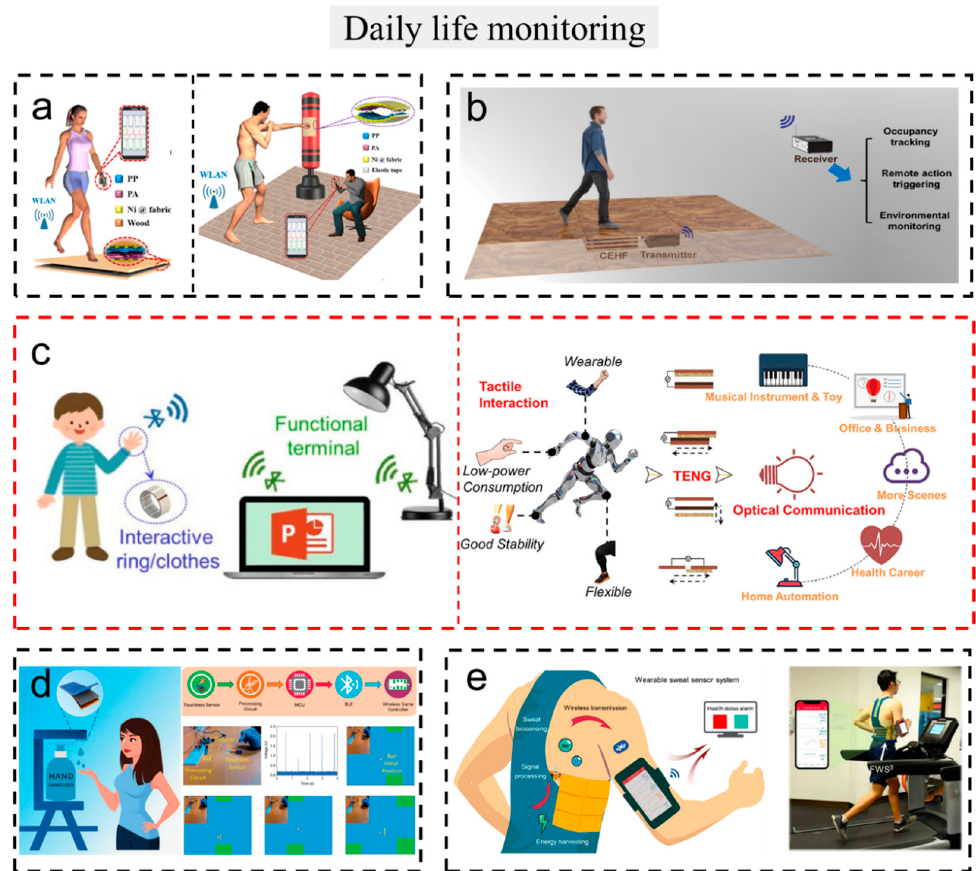
Figure 9. The self-powered wireless sensors and systems based on TENG used in daily life. ( a ) A system is used to collect pedestrian volume and monitor pugilism training. Reproduced with permission [111]. Copyright 2019, Elsevier Ltd. ( b ) Energy-harvesting floor from commercial cellulosic materials for a self-Powered wireless transmission sensor system. Reproduced with permission [112]. Copyright 2021, American Chemical Society. ( c ) A universal and arbitrary tactile interactive system based on self-powered optical communication. Reproduced with permission [113]. Copyright 2020, Elsevier Ltd. ( d ) A self-powered sensor for touchless hand sanitizer. Reproduced with permission [114]. Copyright 2022, John Wiley & Sons. ( e ) Wireless battery-free wearable sweat sensor powered by human motion. Reproduced with permission [115]. Copyright 2020, American Association for the Advancement of Science.